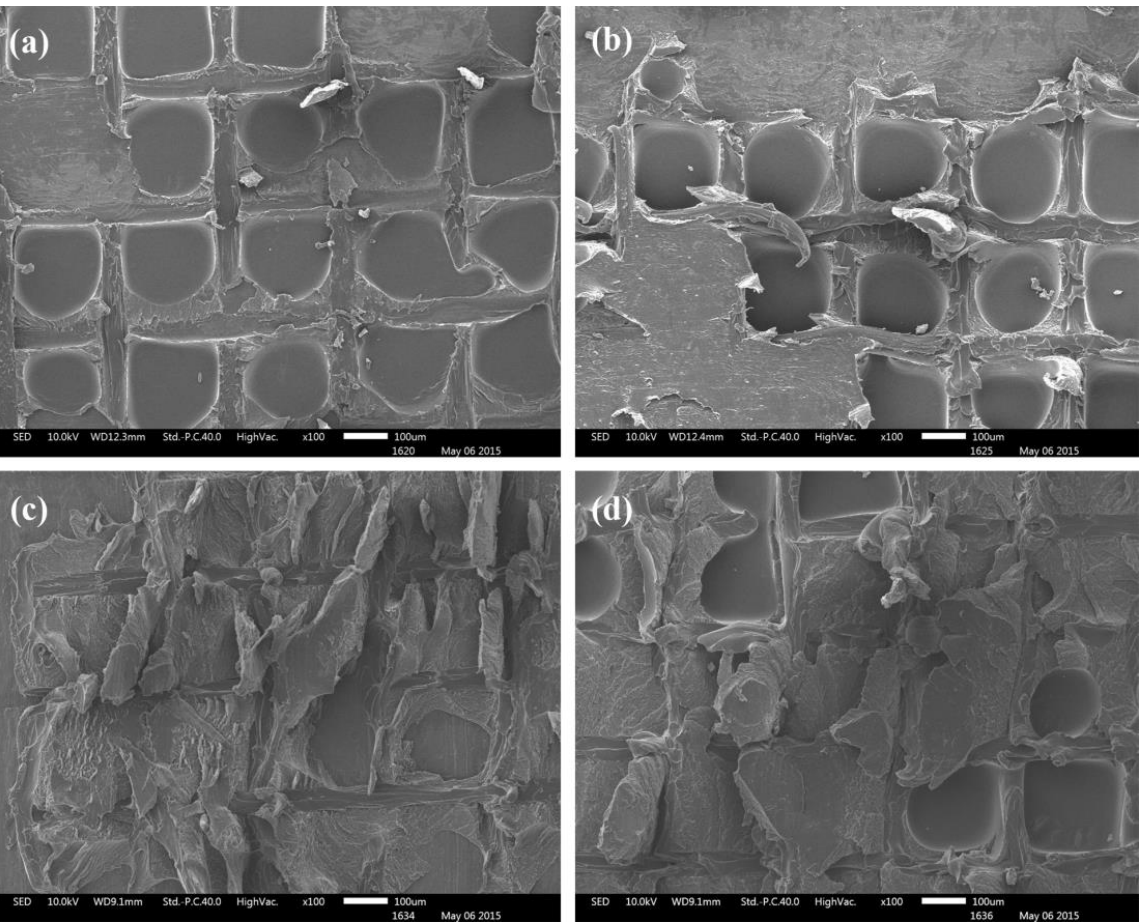
Figure 8. SEM images of BMI adhesive-bonded aluminum joints after testing at different tempera- tures: ( a ) 23 °C; ( b ) 120 °C; ( c ) 150 °C; and ( d ) 200 °C.